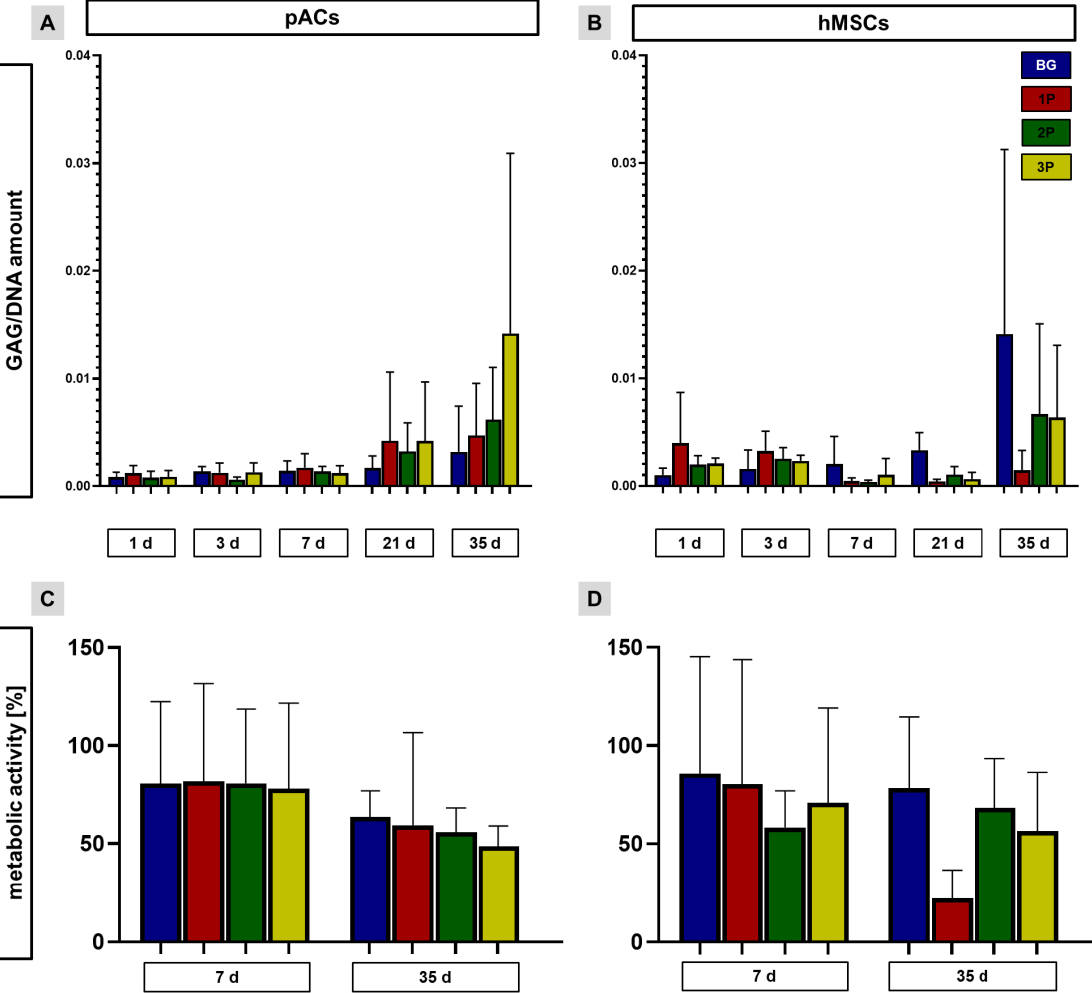
Figure 8. Calculation of the sulphated glycosaminoglycan (sGAG) per DNA amount per scaffolds after 1, 3, 7, 21 and 35 days and the metabolic activity of the cells on the scaffolds after 7 days and 35 days. GAG per DNA amounts of pAC- ( A ) and hMSC-( B ) colonized scaffolds were calculated after 1, 3, 7, 21 and 35 days (d). The metabolic activity of pAC- ( C ) and hMSC- ( D ) colonized scaffolds was measured after 7 and 35 days and was compared to the color change in the assay caused by uncolonized scaffolds. The pure bioactive glass (BG, blue), single (1P, red), twofold (2P, green) and threefold PLGA infiltrations (3P, yellow). Three independent ( n = 3) experiments with cells from three different donors were performed. Two-way ANOVA (post hoc Tukey Test) for comparison between the groups. No significances pACs = porcine articular chondrocytes and hMSCs = human mesenchymal stem